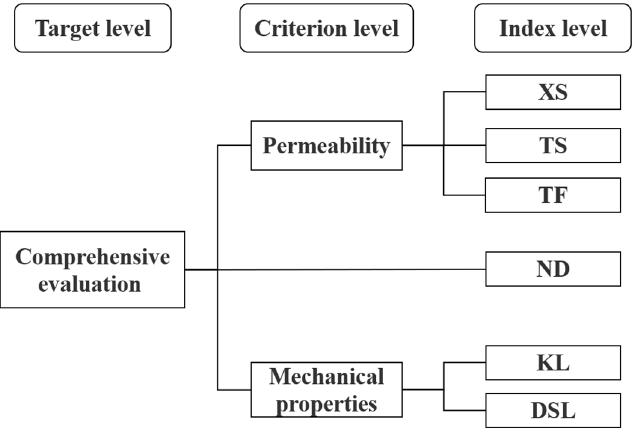
Figure 2. Decision tree for comprehensive evaluation of membrane materials.